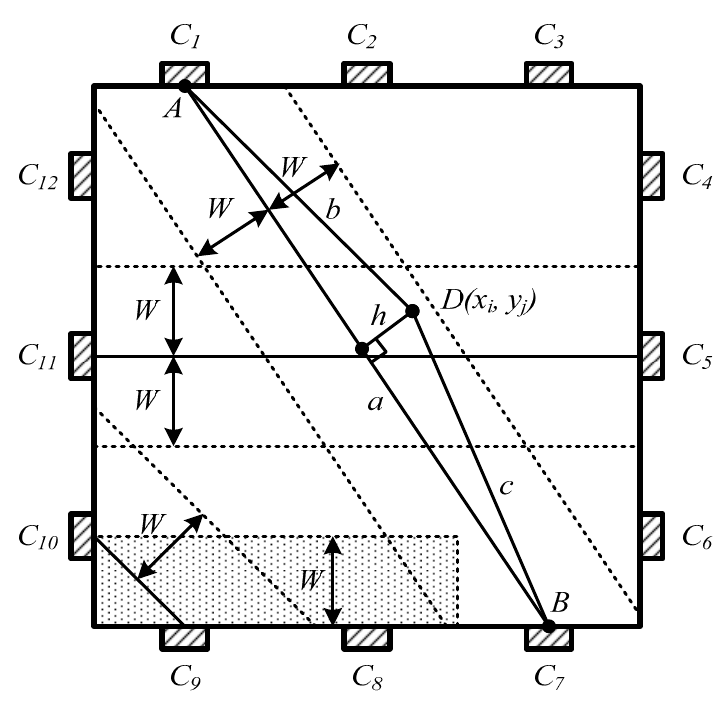
Figure 2. Schematic representation of a sensor film with twelve contacts C 1 –C 12 . Dotted lines show the boundaries of conditional conduction channels with a width of 2 W between pairs of contacts.